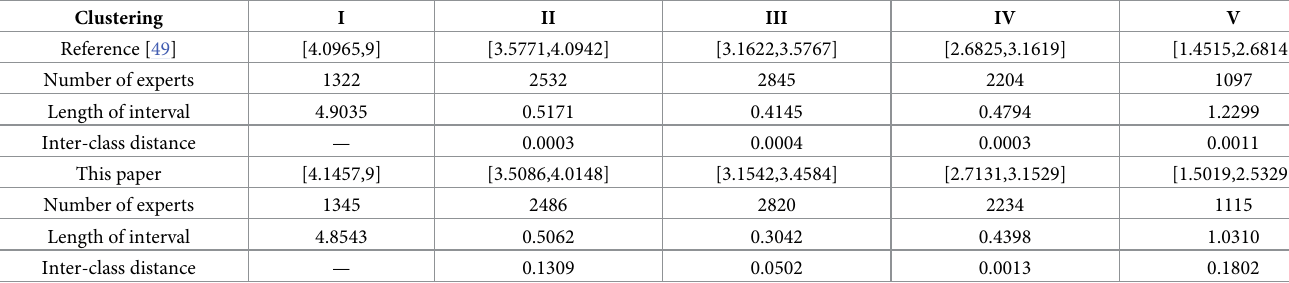
Table 15. Dynamic competency clustering in reference [49] and this